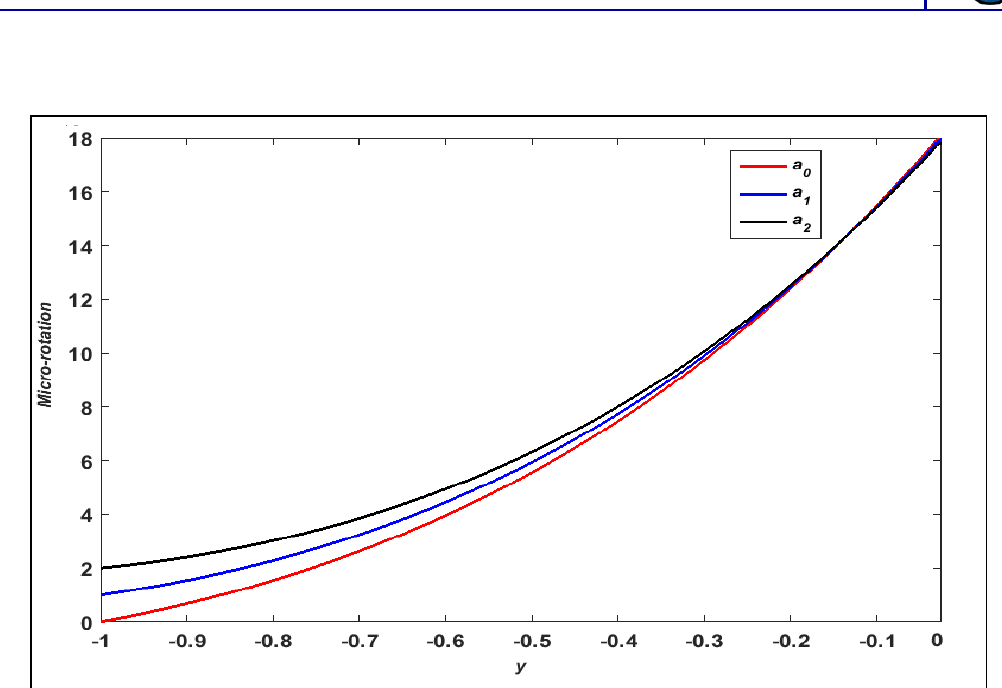
Figure 8. Micro-rotation profile with the fuzzy boundary.